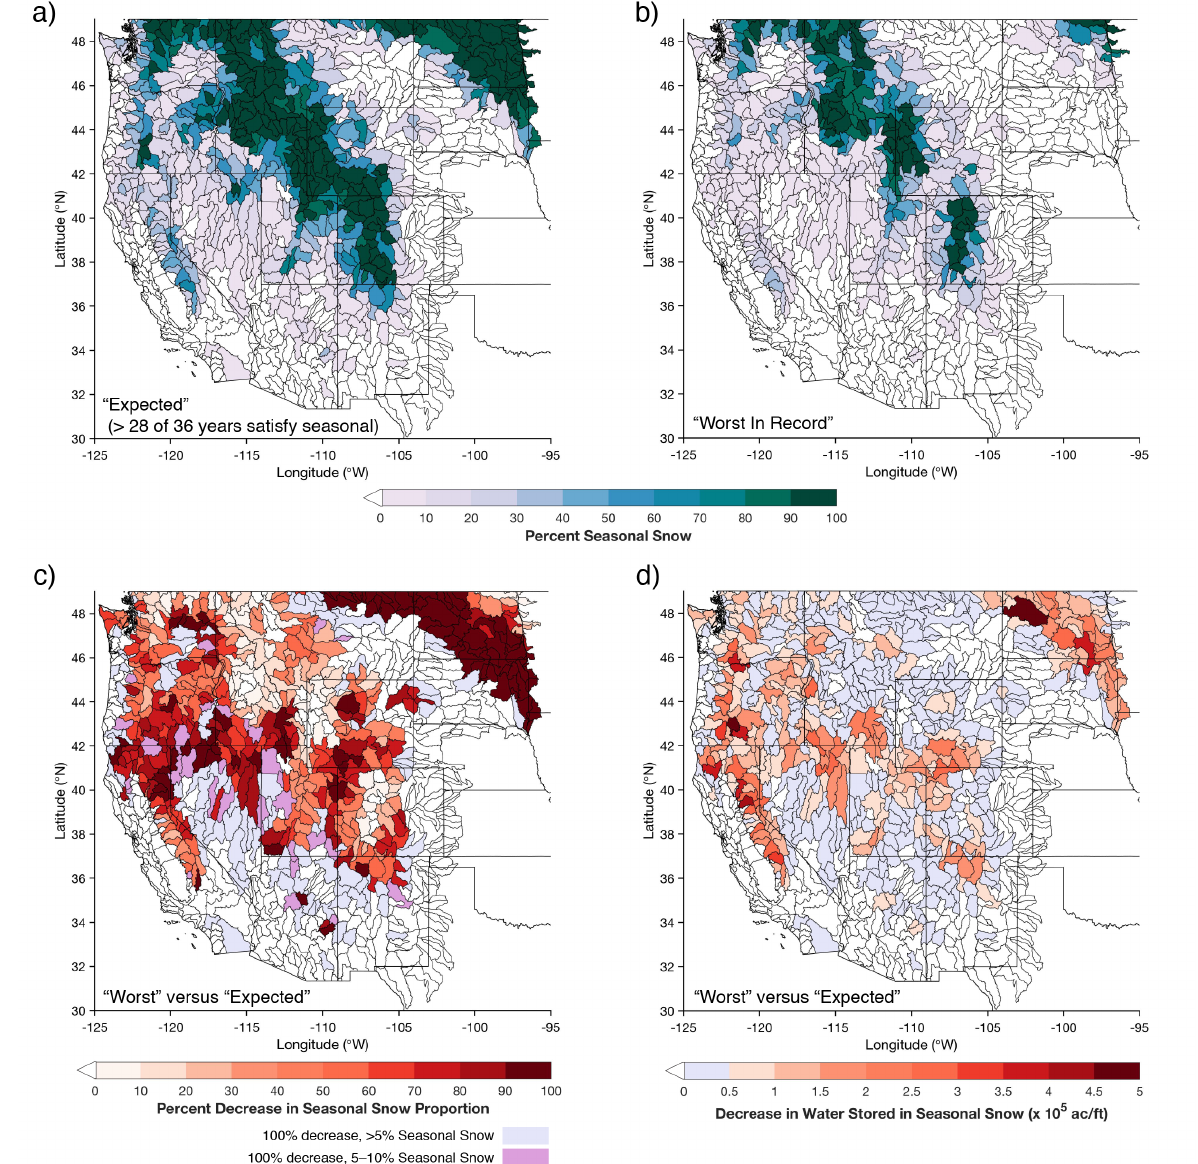
Figure 7. Percent seasonal snow aggregated to HUC-8 watersheds across the western U.S., defined using the snow seasonality metric, for: ( a ) “Expected” seasonal snowpacks (defined as more than 28 of 36 years (78%) satisfying a seasonal snowpack) and ( b ) “Worst In Record”, or the fewest seasonal snowpack cells in a watershed (cf. Figure 2c). Only grid cells receiving snow (seasonal or ephemeral) were considered. ( c ) Percent decrease in seasonal snow proportion for the “Worst In Record” years versus the “Expected” conditions. Watersheds with less than 5% (5–10%) seasonal snow experienced 100% losses in the worst years and are shown as light purple (purple) to reduce visual impact. ( d ) Decrease in water stored in seasonal snow (units of 100,000 ac / ft ) in “Worst In Record” years versus “Expected”